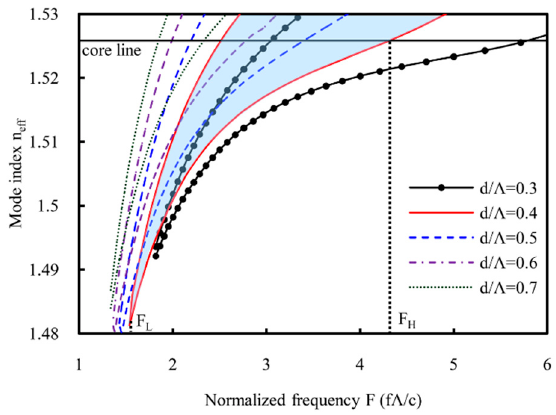
Figure 2. Bandgaps of cladding structure for the designed THz LC-MOF without external static electric field across the fiber, ε LC = diag